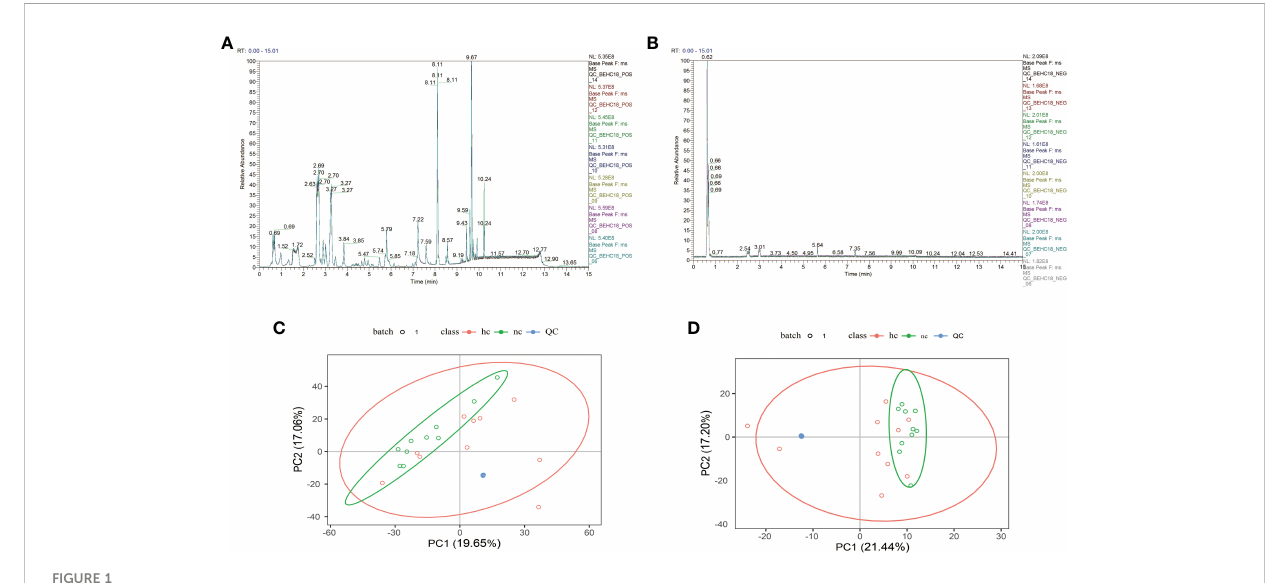
TABLE 1 Number of compounds and number of compounds with identi fi cation information detected in both the positive and negative ion modes. Mode Number of compounds Number of compounds with identi fi cation information Positive ion mode (pos)